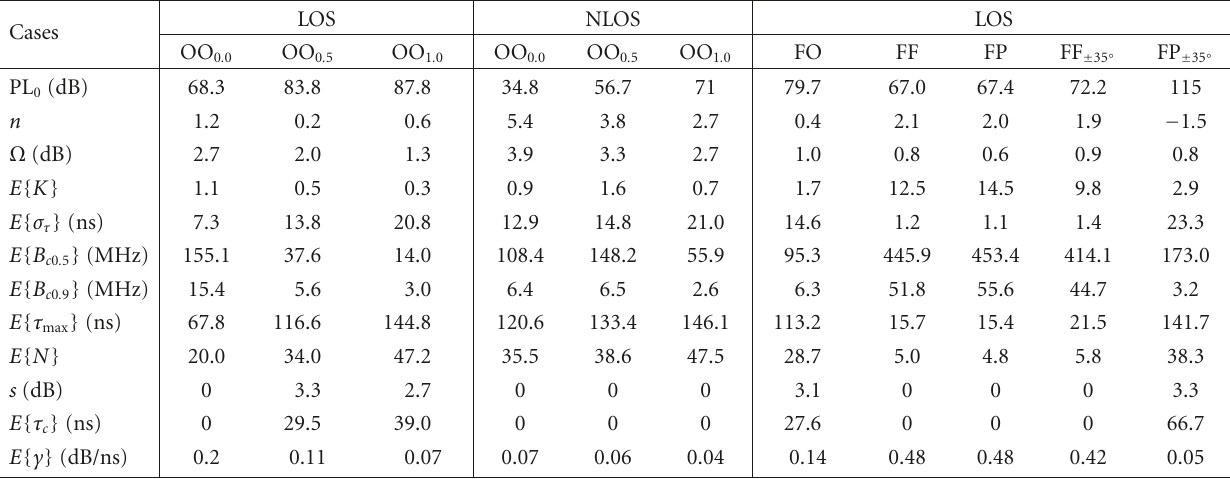
Table 3: The log-distance model parameters { PL 0 , n , Ω } , the mean values of K , σ τ , B c , τ max , and N for various configurations, and the PDP shape parameters { s , τ c , γ }